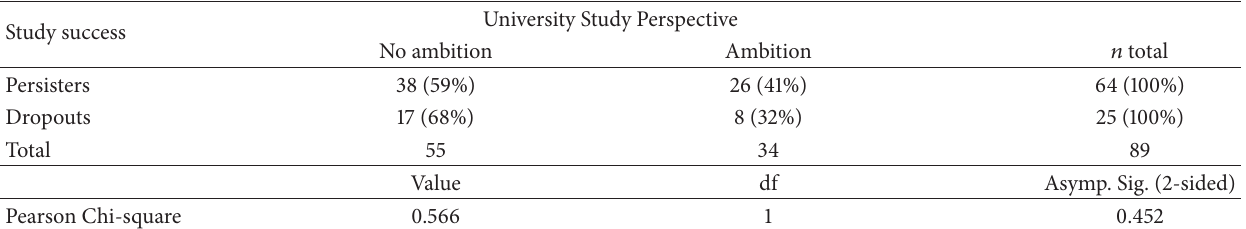
Table 3: The relation between study success and the intention to switch to the university ( 𝑛 = 89 ).